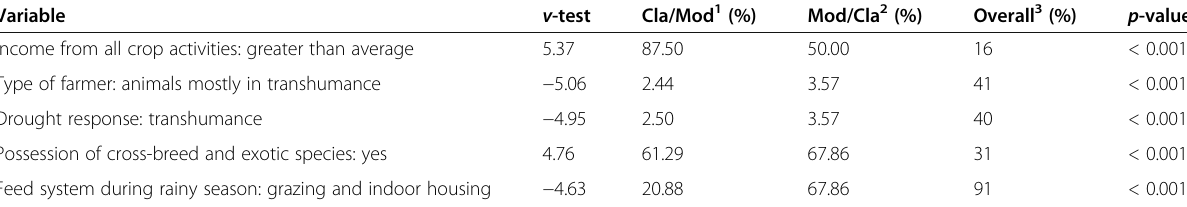
Table 7 Top 5 relevant categorical variables that best describe the 28 farms from cluster 3. Overall sample n = 100 farms Variable v